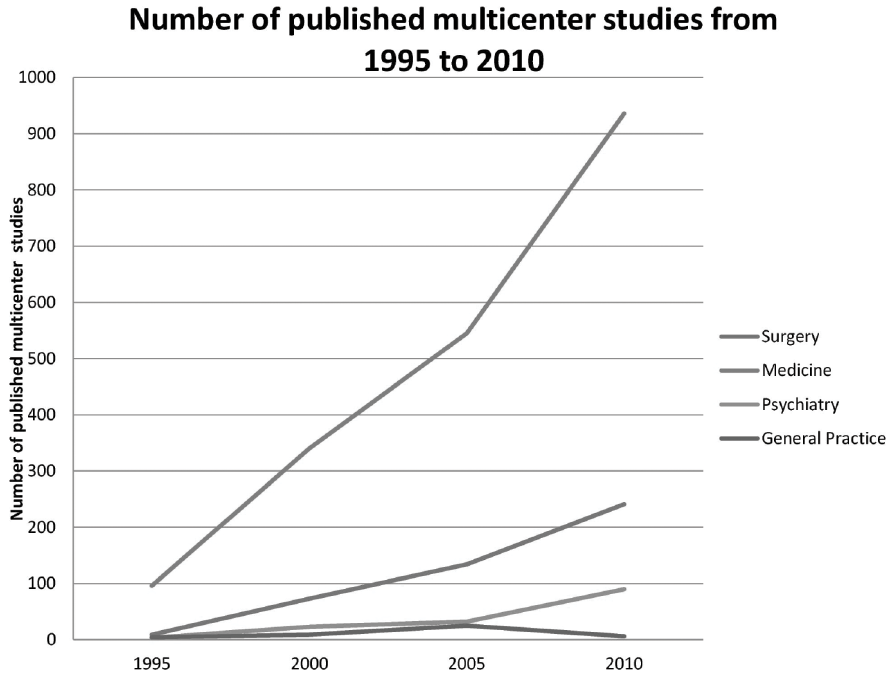
Figure 3. Number of published multicenter studies from 1995 to 2010.